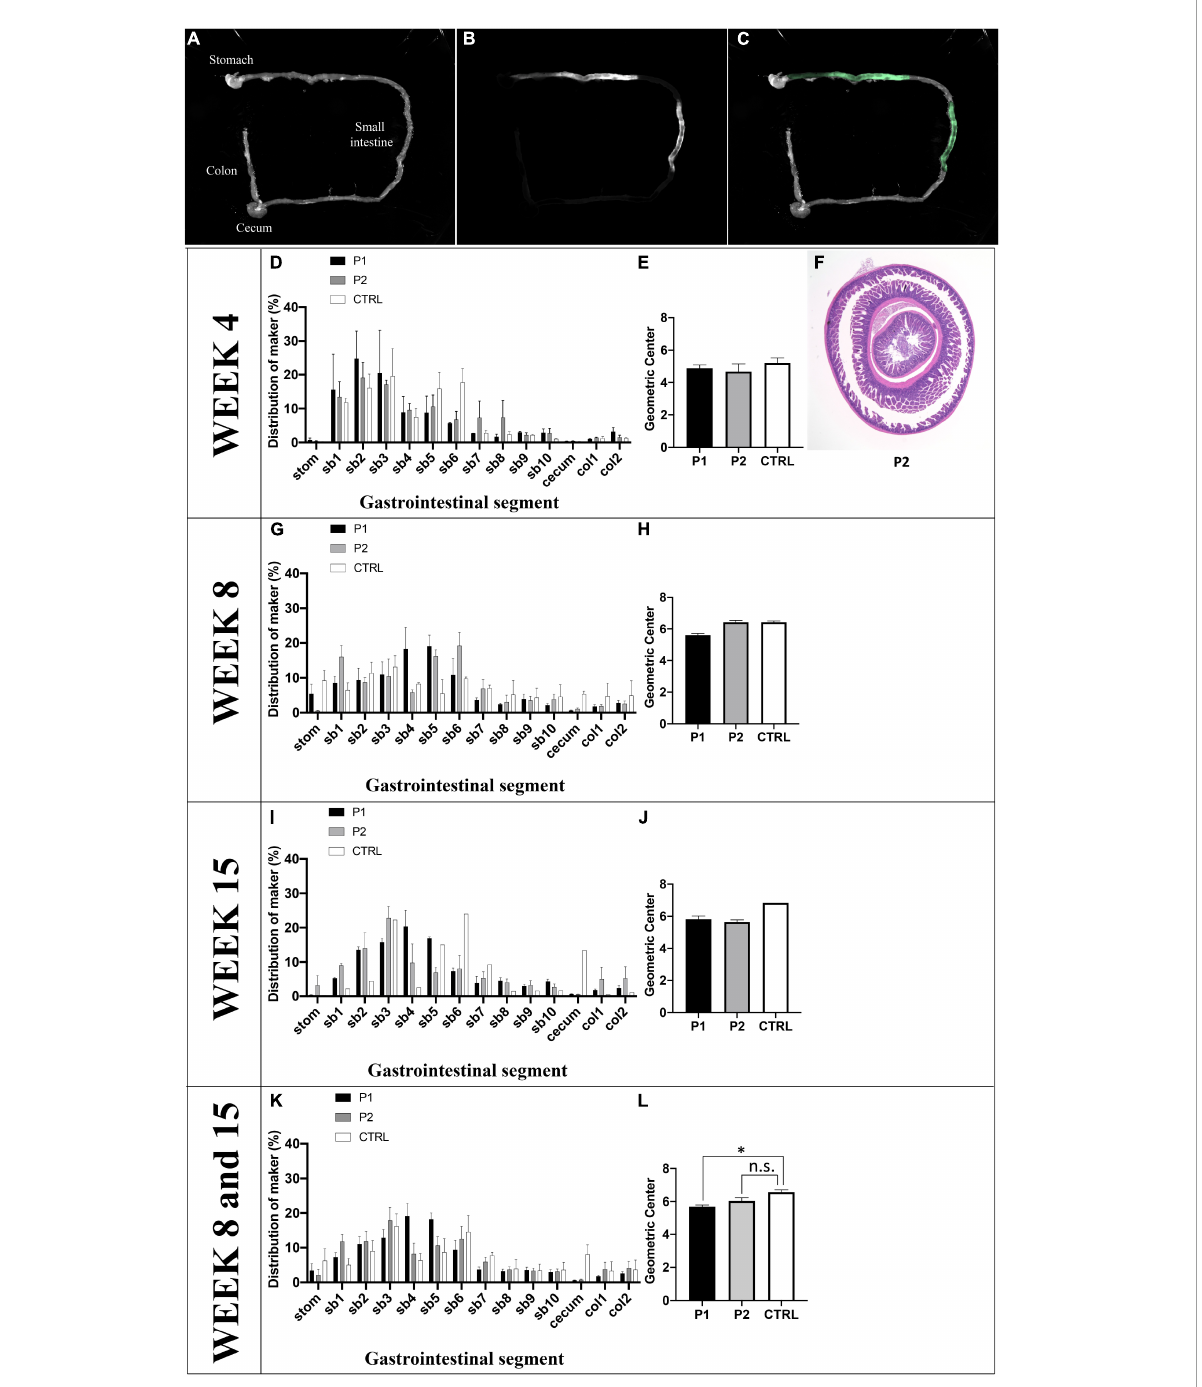
FIGURE4 Quantification of intestinal transit. (A) Normal illumination mode, (B) fluorescent mode, and (C) merge of intestinal transit from one control mouse as a representative image. (D–J) GI motility in vivo was assessed by the intestinal distribution of non-absorbable fluorescein-labeled dextran (FD70). (D) At week 4, (G) week 8, and (I) week 15, the distribution patterns of FD70 was plotted in a histogram, indicating results from each group. (E) At week 4, (H) week 8, and (J) week 15, the geometric center (GC) of the mice are depicted using a histogram. (F) The histological findings of ileoileal intussusception in one mouse treated with peptide 1 on day 30 are shown. (K) The distribution patterns of FD70 of the three groups are plotted in a histogram, and (L) the GC values of the three groups are shown in a histogram. The fluorescent intensity for the entire GI tract was calculated using ImageJ 1.52a. Data are expressed as the percentage of fluorescence intensity per segment of 14 parts (stom, stomach; sb, small bowel segments 1–10; cecum, col, colon segments 1–2) and is plotted in a histogram. The GC was calculated using the following formula: S (% FD70 per segment × segment number)/100. Asterisk denotes statistical